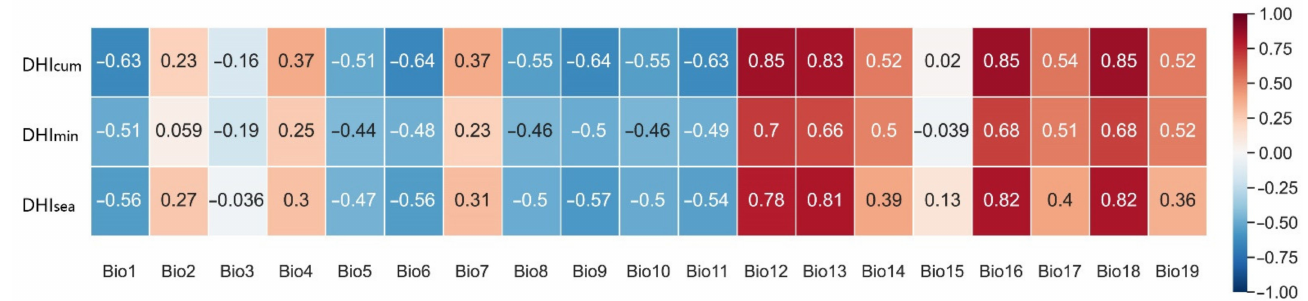
Figure 6. Correlations between the DHIs and 19 BIOCLIM climate variables, showing the relationship between the DHIs and environmental information that may influence species richness.